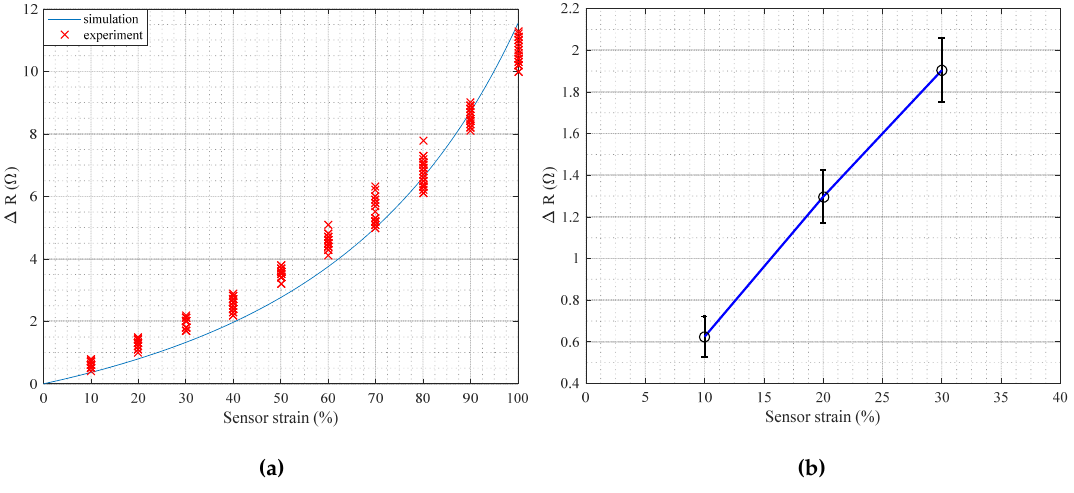
Figure 5. Resistance change of the soft sensor with respect to the strain; ( a ) 10% ∼ 100% strain; ( b ) 10% ∼ 30% strain.